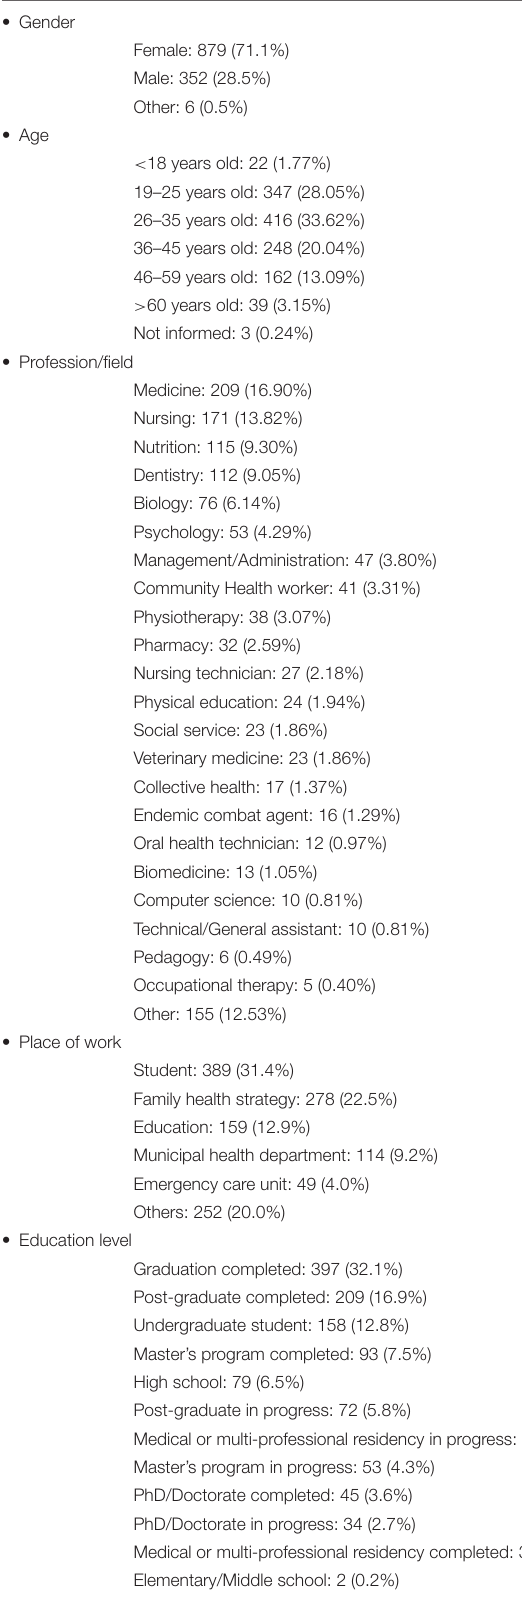
TABLE 2 | Sociodemographic profile ( n = 1,237). • Gender Female: 879 (71.1%) Male: 352